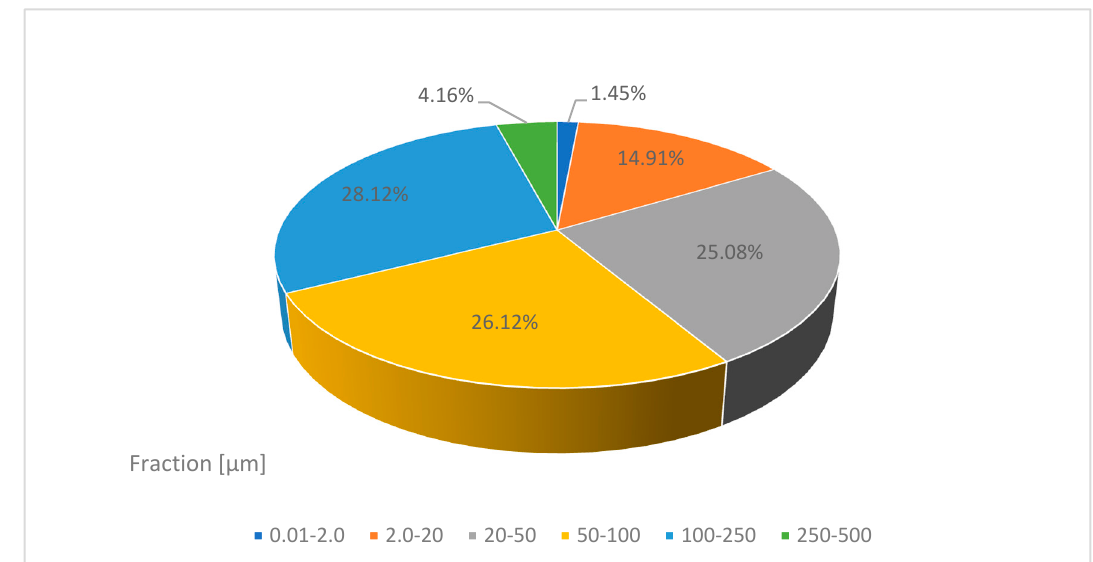
Figure 9. Volumetric distribution of the particle fractions of fly ash from thermal treatment of sewage sludge.